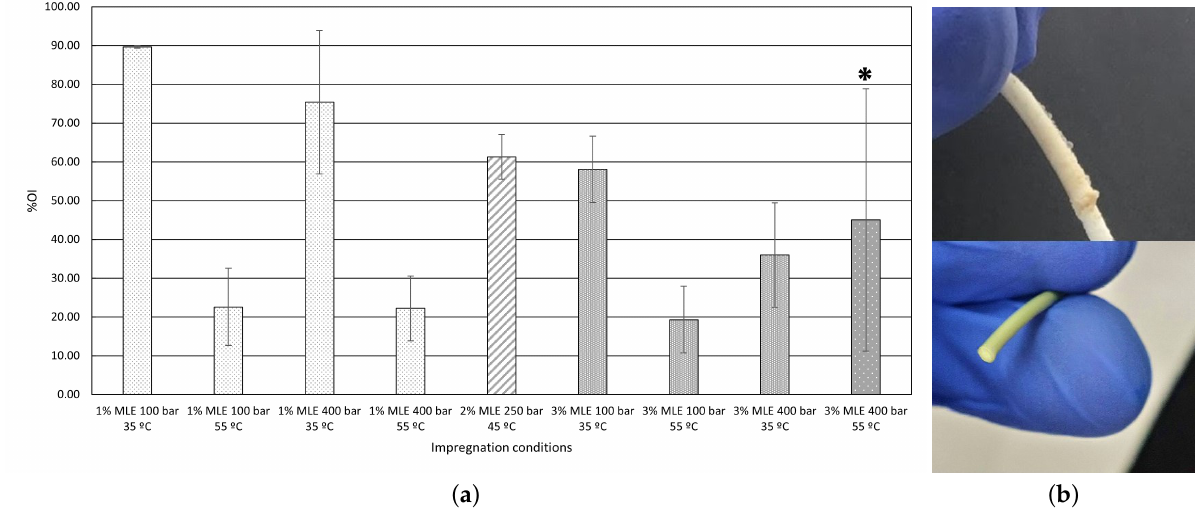
Figure 8. ( a ) Percentage of oxidation inhibition (%OI) displayed by MLE-impregnated PLA filaments. * Structural damages. ( b ) Examples of damaged filament impregnated at 400 bar and 55 ◦ C with 3% of MLE (top) and a representative sample of a non-damaged filament.